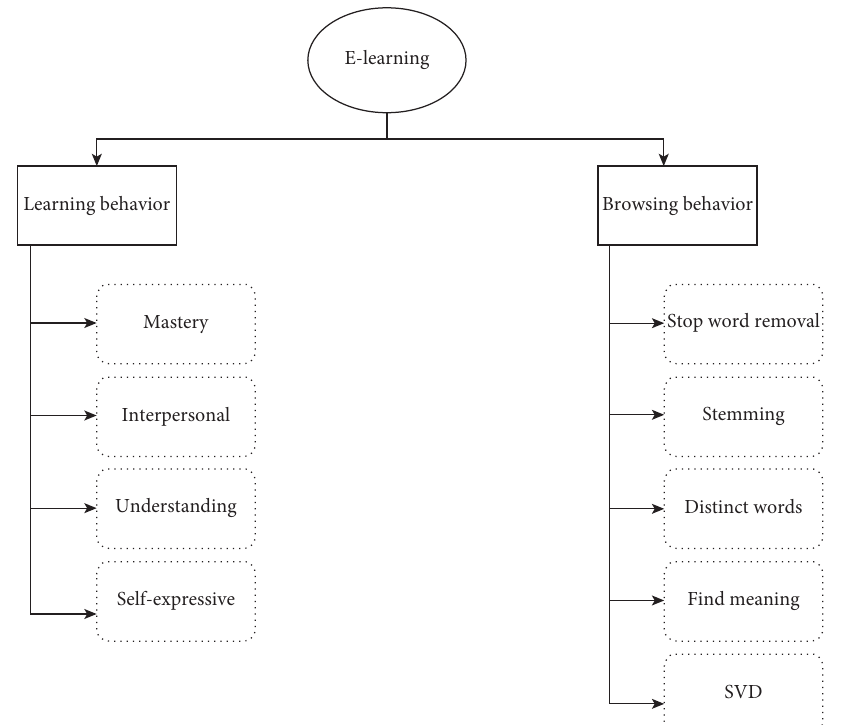
Figure 1: Structure of e-learning